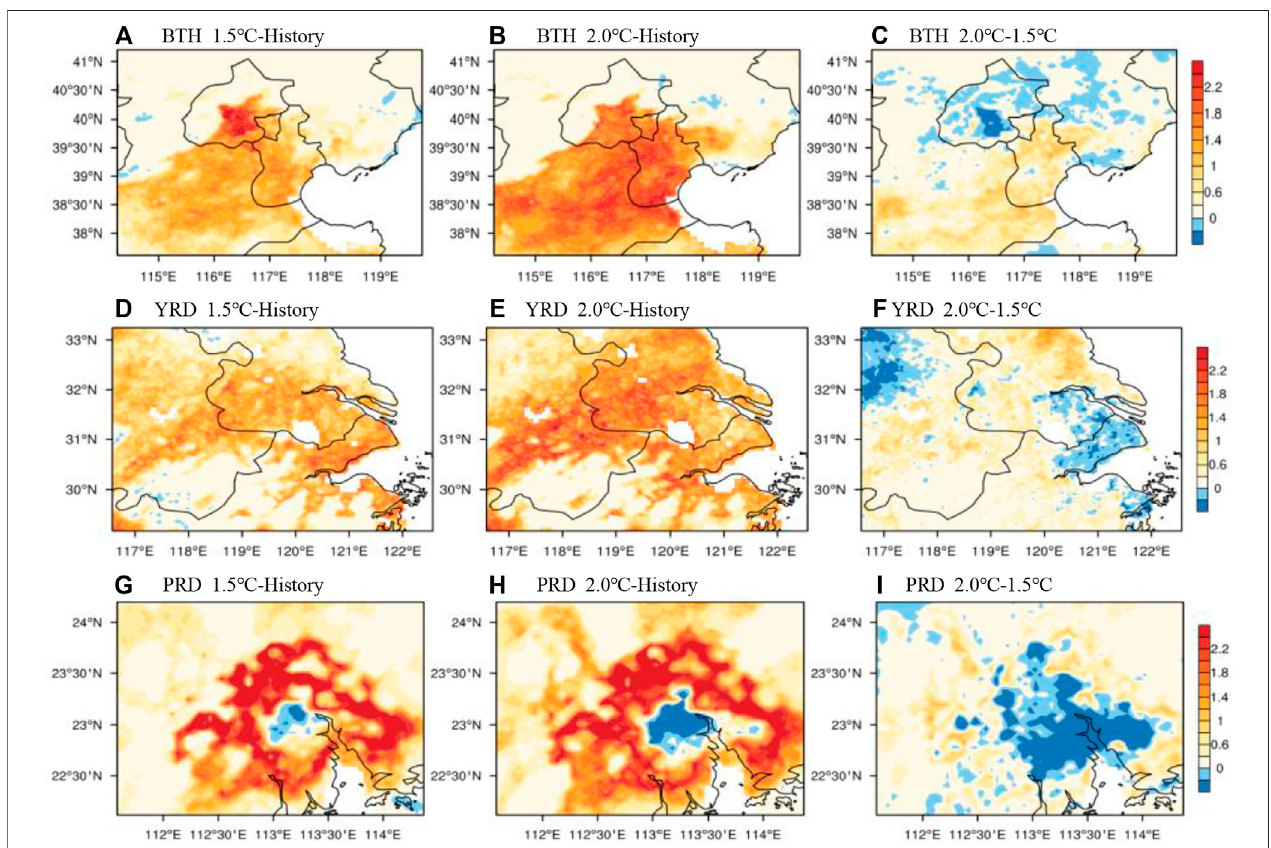
FIGURE 6 | Spatial distributions of the difference in HW frequency over the three urban agglomerations between Exp 1.5-run and Exp HIS-run (A,D,G) , between Exp 2.0-run and ExpHIS-run (B,E,H) ,and betweenExp 2.0-run and Exp1.5-run (C,F,I) .Thecoloredarea indicates thatthe changeisstatisticallysigni fi cantat the95% con fi dence